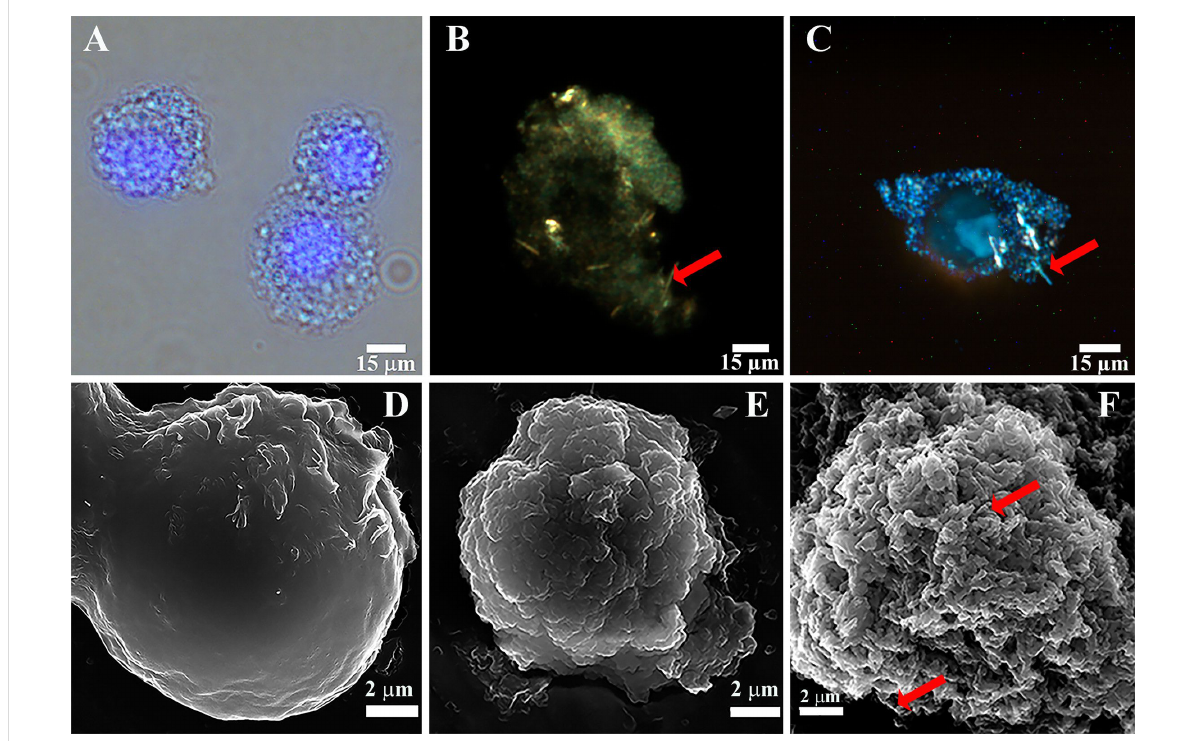
Figure 2: (A) optical/fluorescence microscopy image of live HeLa cells coated with halloysite-doped silica shells (nuclei are stained with DAPI); (B, C) dark-field microscopy images of live HeLa cells coated with halloysite-doped silica shells; scanning electron microscopy images of (D) intact HeLa cells, (E) HeLa cells coated with pure silica shells and (F) HeLa cells coated with halloysite-doped silica shells. Red arrows indicate halloysite